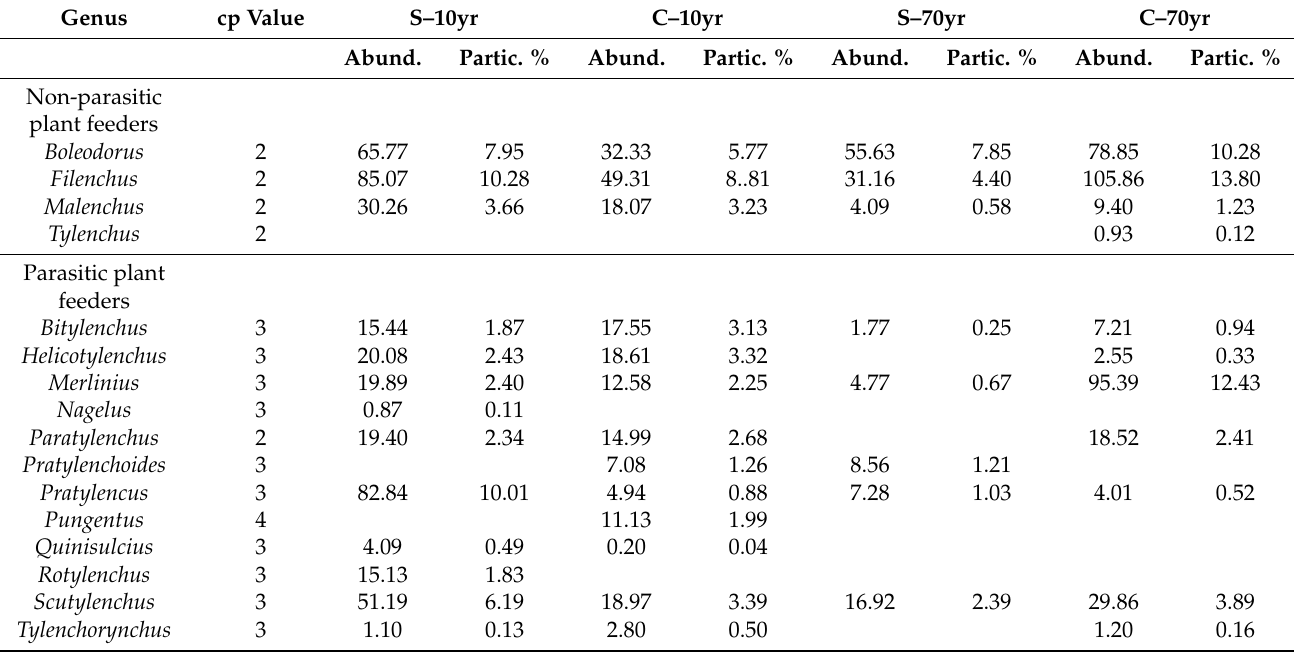
Table 4. Mean abundance (individuals per 100 g dry soil) of nematode genera and % participation to the total community in the rhizospheres of the alien Solanum elaeagnifolium (S) and the native Cichorium intybus (C) in recently (10 yr) and historically (70 yr) invaded